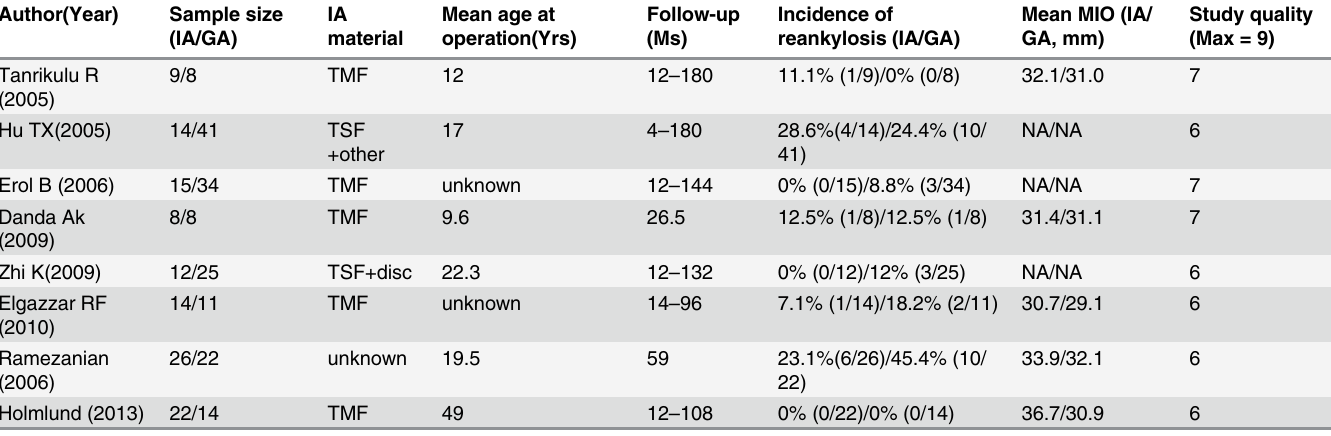
Table 1. The characteristics of the studies included in the